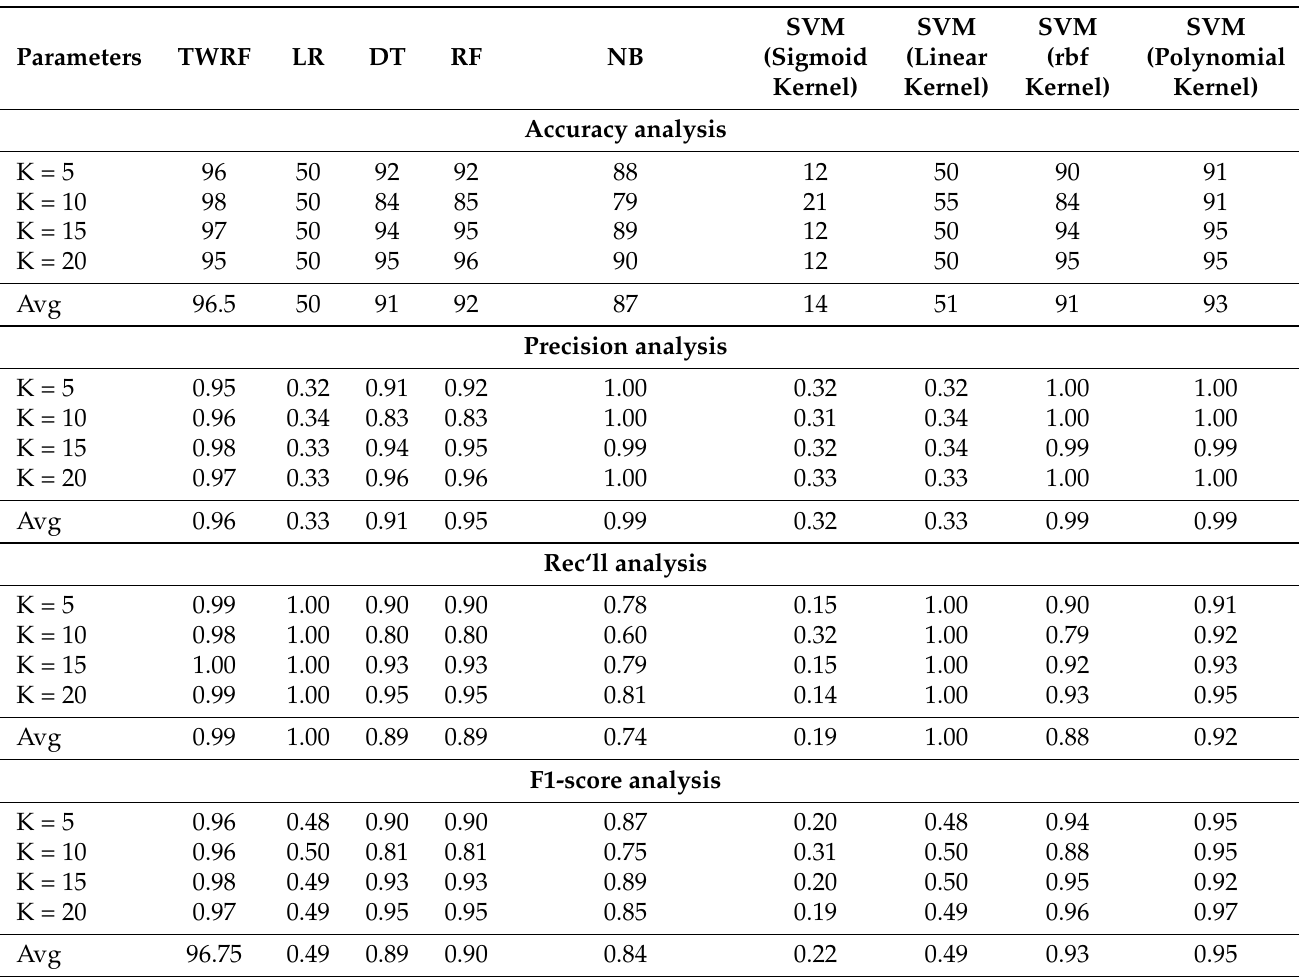
Table 5. K-fold analysis.